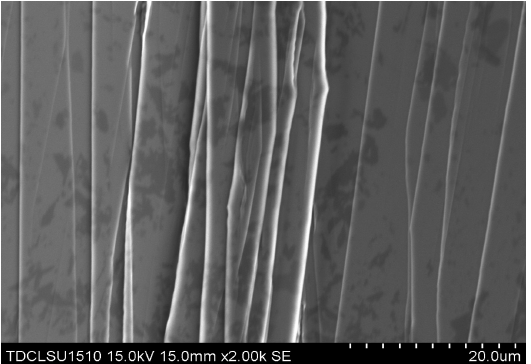
Figure 4. SEM images of surface appearance with shear bands of Fe Si B ribbon after bending. 90 5 5